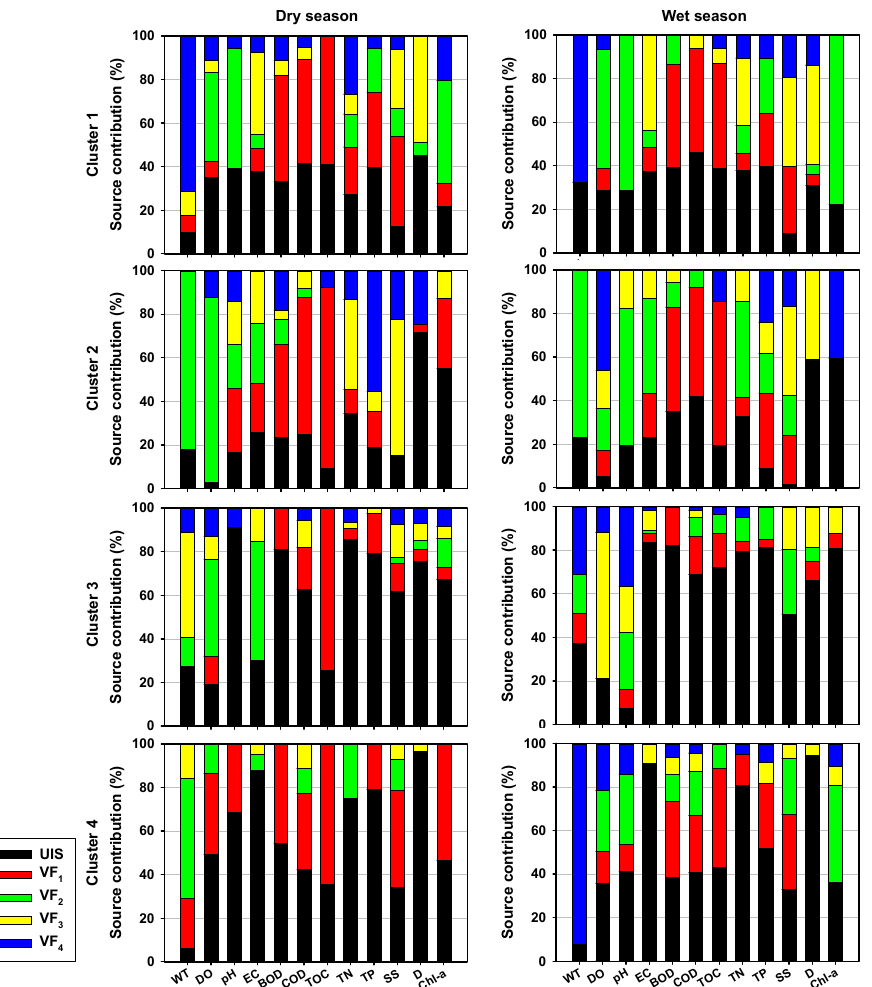
Figure 6. Source contribution (%) for each variable in cluster 1, 2, 3, and 4 in the dry and wet seasons (VF: rotated components using varimax method).